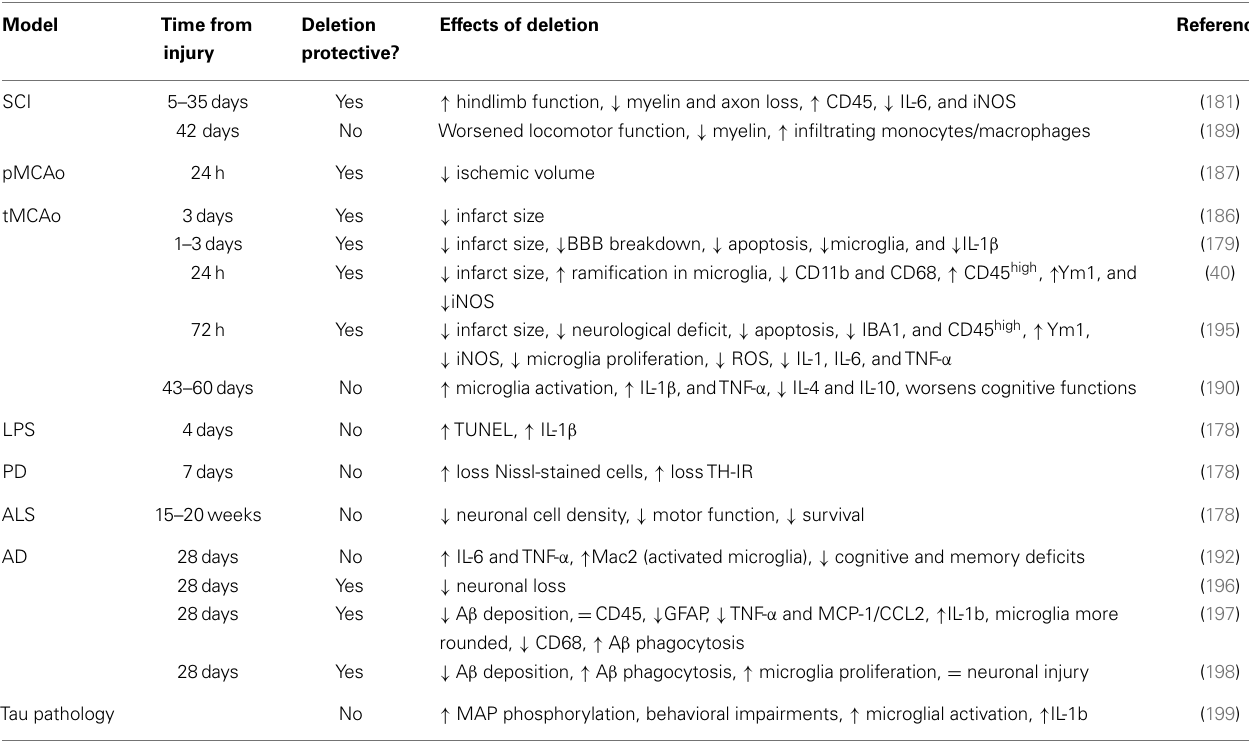
Table 1 | Effects of CX3CR1 deficiency in different models of CNS diseases